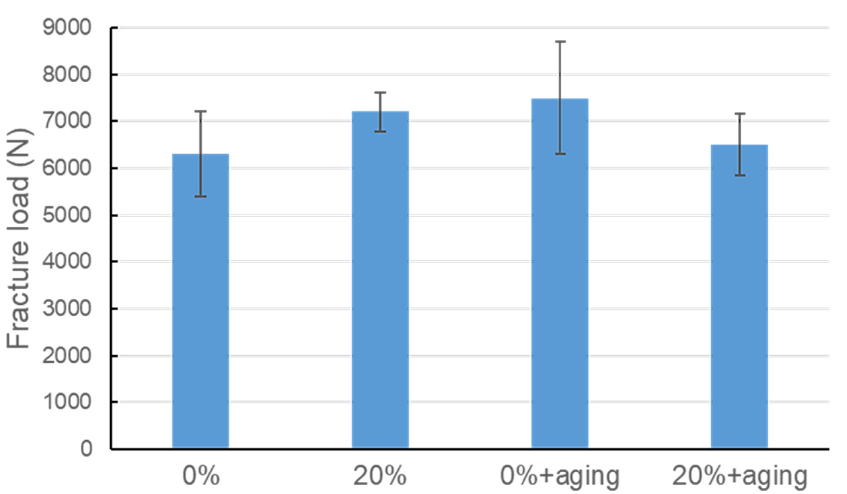
Figure 5. Fracture loads of test PEEK crowns after compression tests, including 0% TiO 2 (without aging), 20% TiO 2 (without aging), 0% TiO 2 +aging, and 20% TiO 2